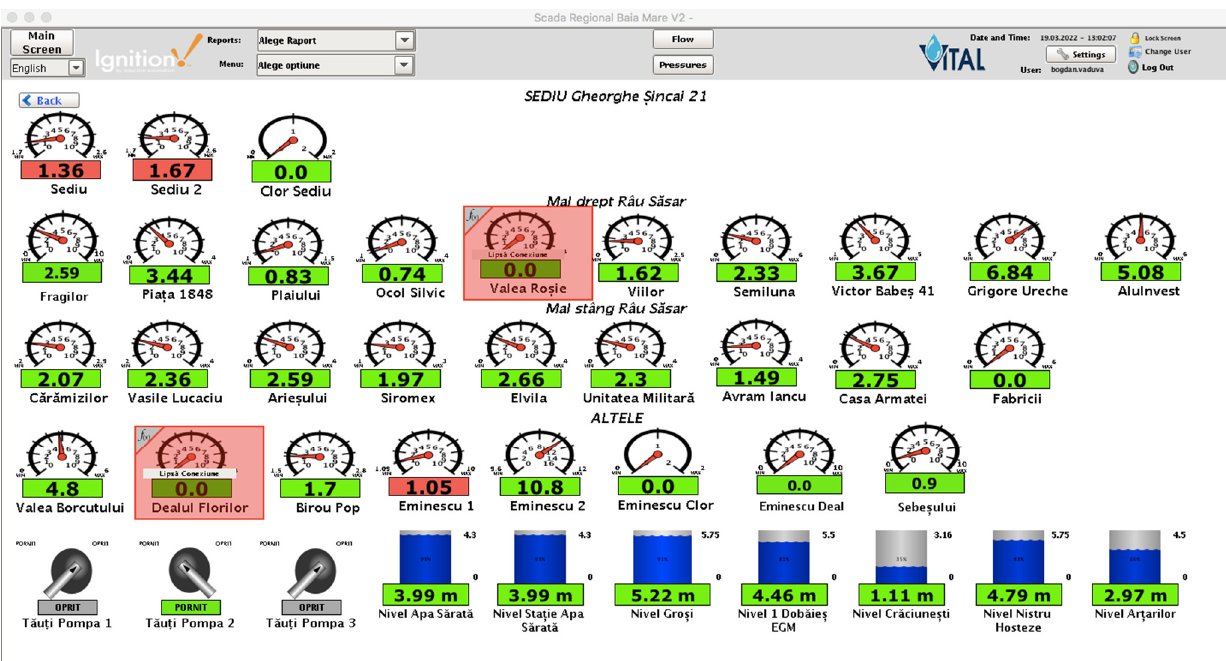
Figure 5. Custom view for a user with Operator role. (green means that the value shown it’s within normal limits, red means otherwise)